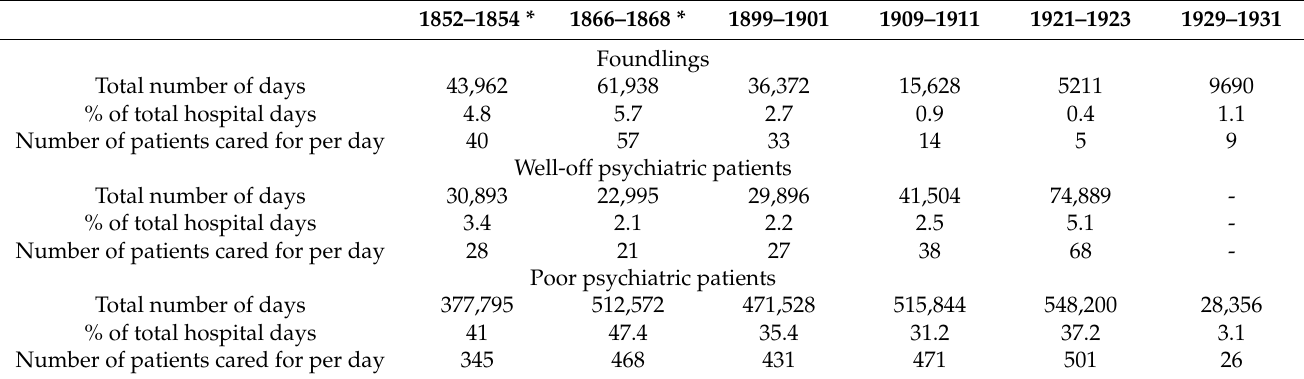
Table 1. Total number of days spent by foundlings and other population groups in the Hospital General de Valencia,